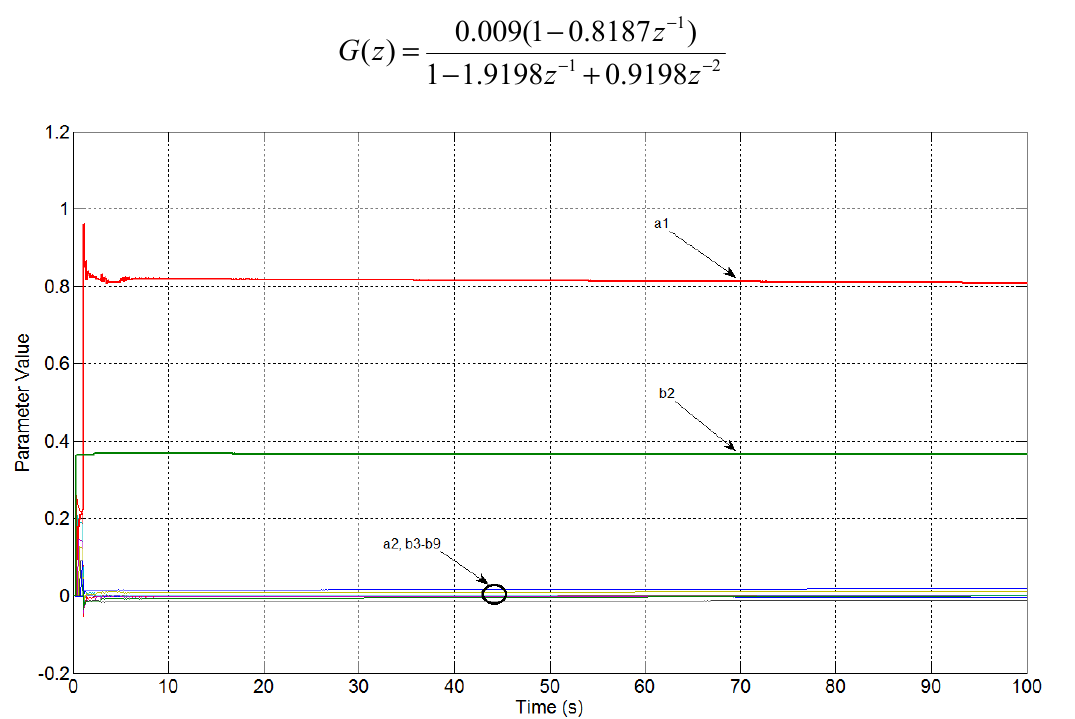
Figure 6. Evolution of identified process parameters for the model used in the experiments. The two dominant parameters ( b 2 and a 1 ) are shown